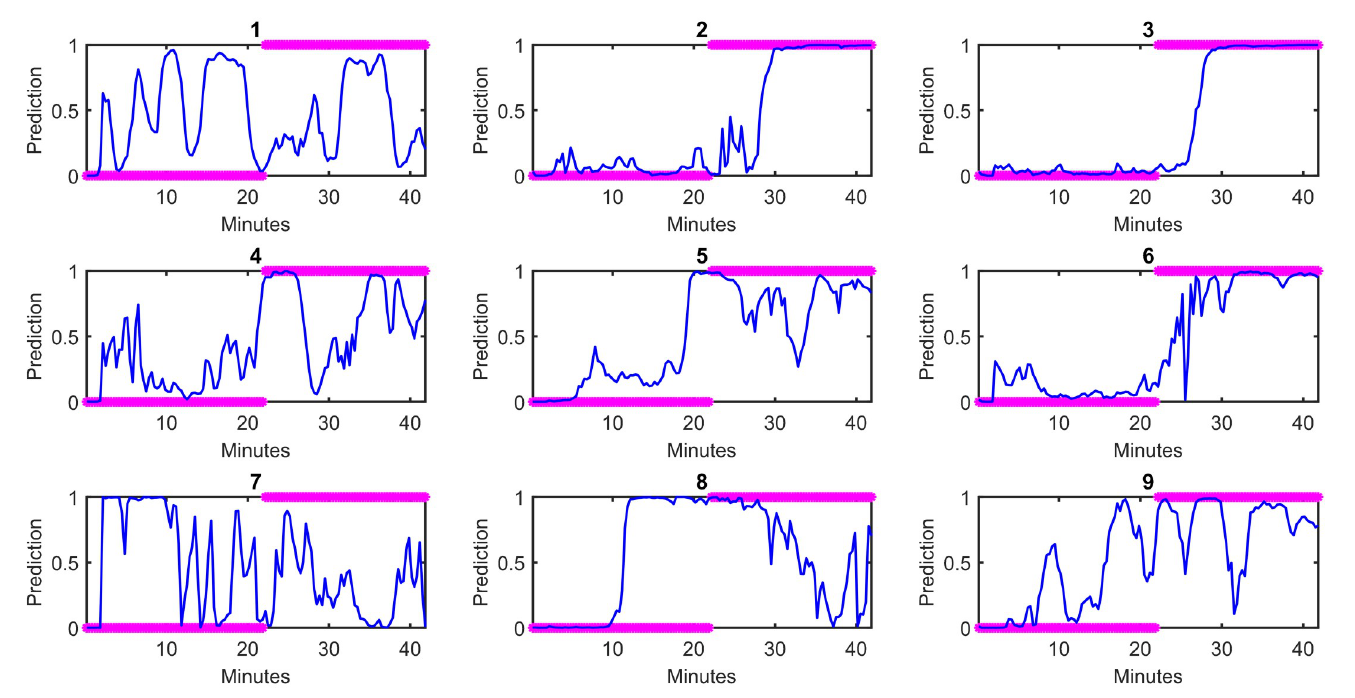
Fig 6. Autonomic predictions by subject from the best logistic regression model for Question 2. Fig 6 allows for better visualization of the nuanced autonomic dynamics immediately around loss of consciousness that were not visible in Fig 5. With these nuanced autonomic, it is clear that the autonomic shifts are rarely aligned exactly with behavioral changes. While it is difficult to annotate behavioral changes on a continuum, autonomic dynamics allow for exactly that. Subject 4 shows the best alignment between autonomic and behavioral changes. Subjects 2, 3, and 6 exhibit delayed autonomic shifts compared to behavioral changes, while Subjects 5, 8, and 9 exhibit earlier autonomic changes compared to behavioral changes. Subjects 1 and 7 exhibit a more complex and variable dynamic that may have also been affected by phenylephrine administration around the time of loss of consciousness.